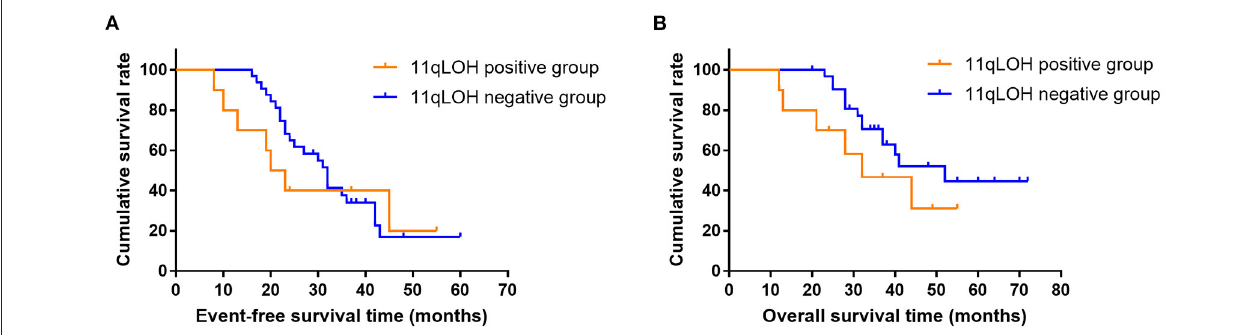
that 11qLOH tumors are diagnosed at an older age (27). This study’s results confirmed this finding: the 11qLOH positive group had a higher rate of patients aged > 18 months at the time of diagnosis ( p =